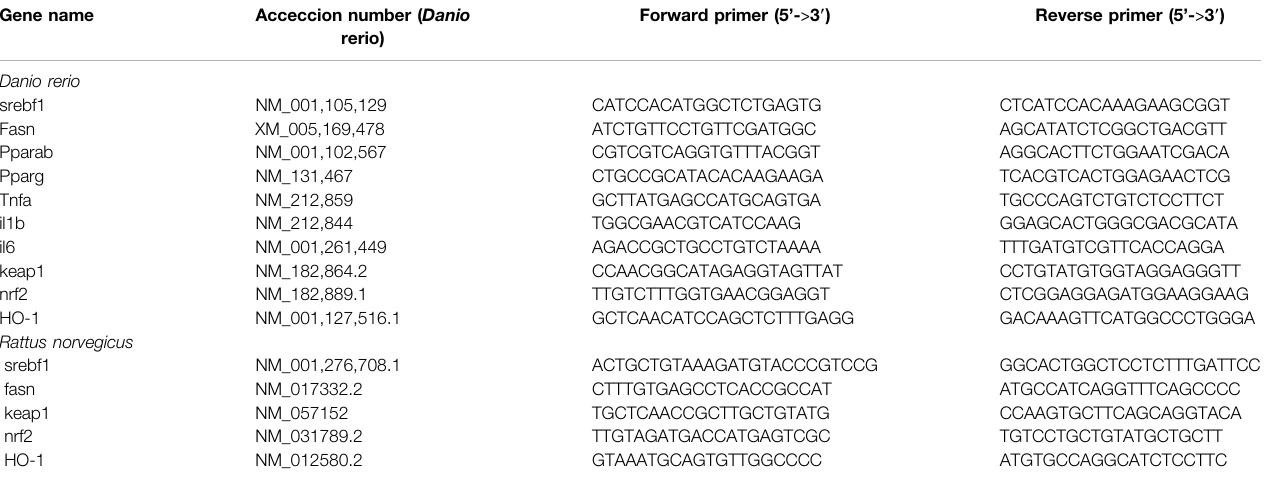
TABLE 1 | Speci fi c sequences of primers used in